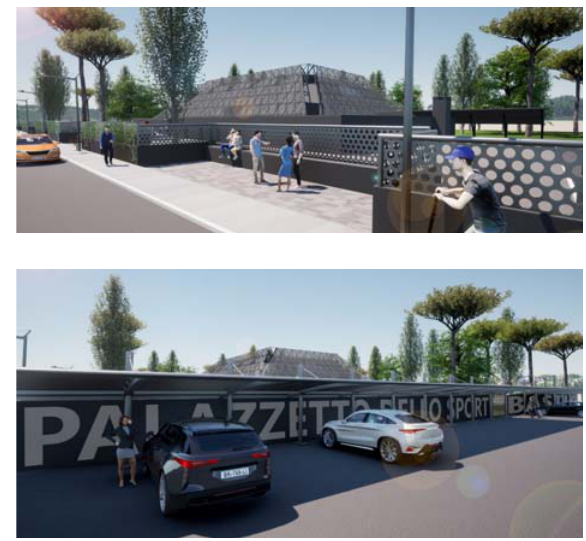
Figure 11 . Simulation of the redevelopment of the urban space with the courts as meeting places and the front with the photovoltaic